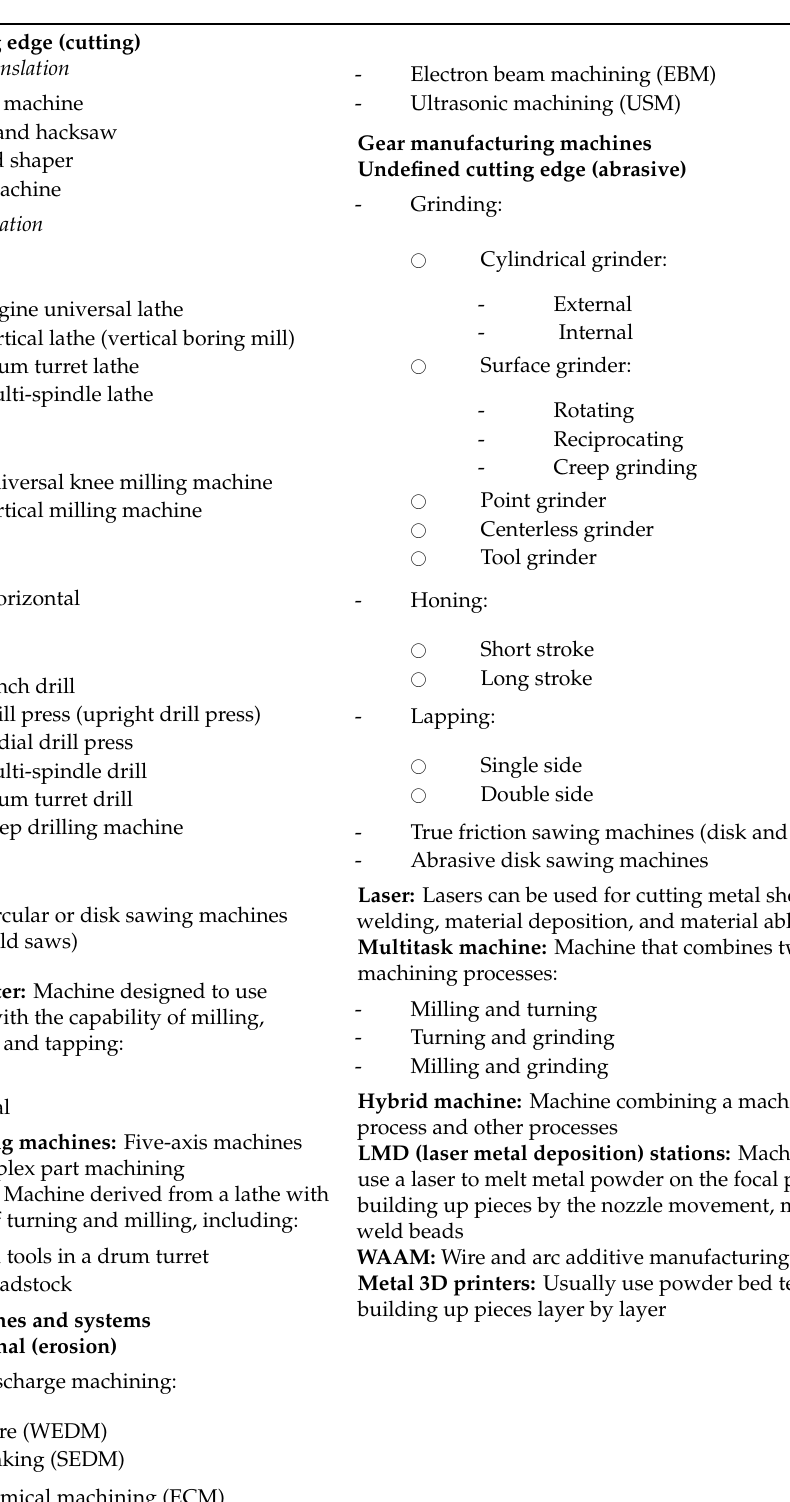
Table 1. Current classification of machine